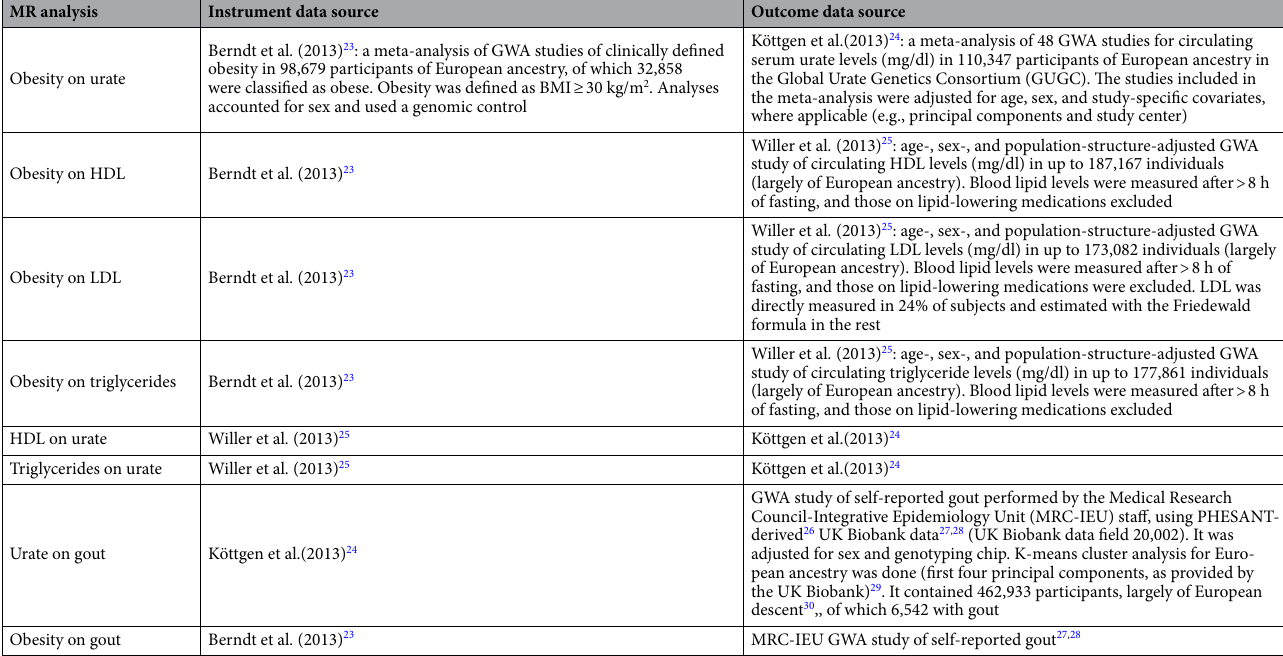
Table 1. Univariable MR analyses and GWA data sources.